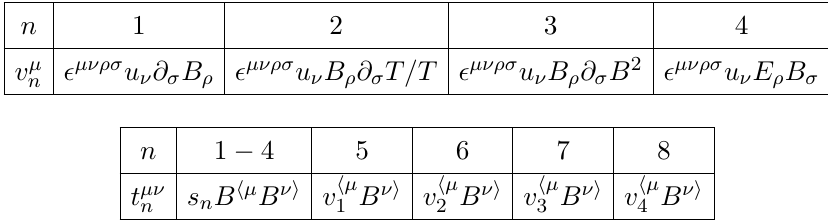
is the Poynting vector. 4